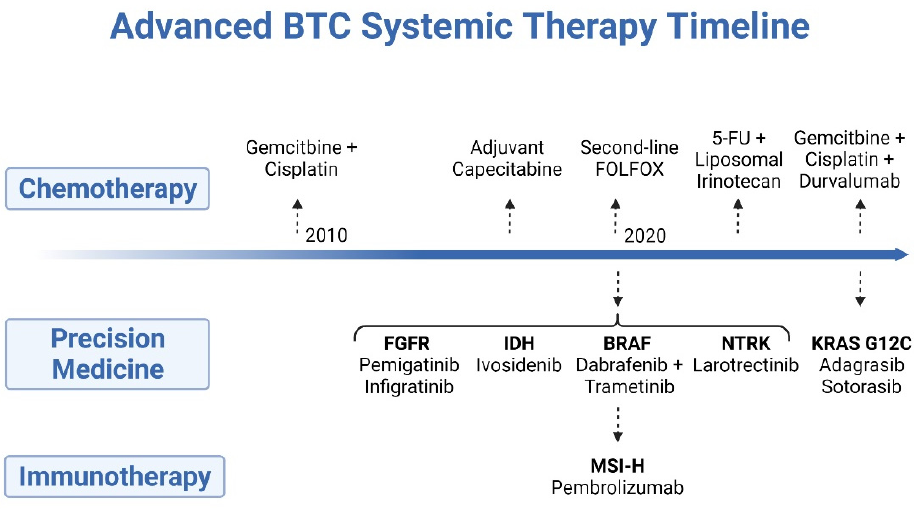
Figure 1. Timeline of systemic treatments developed for the treatment of advanced biliary tract can-